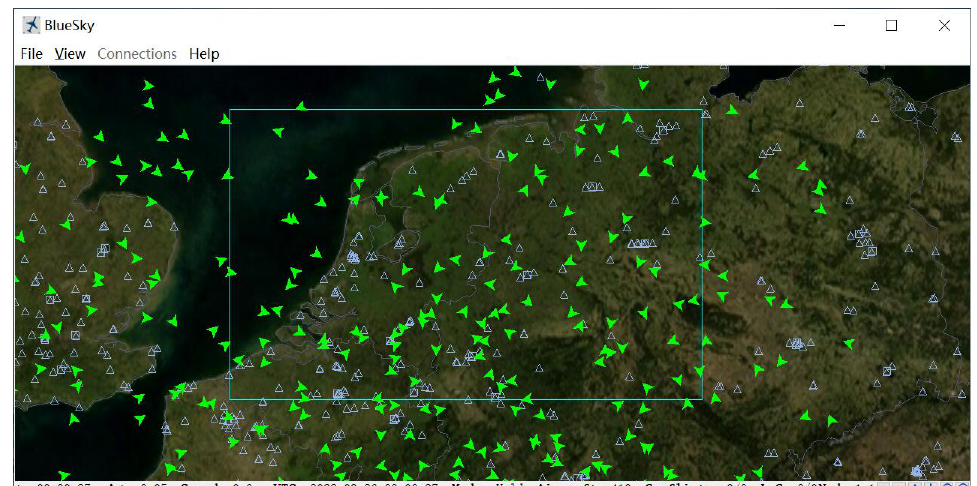
Figure 5. BlueSky user